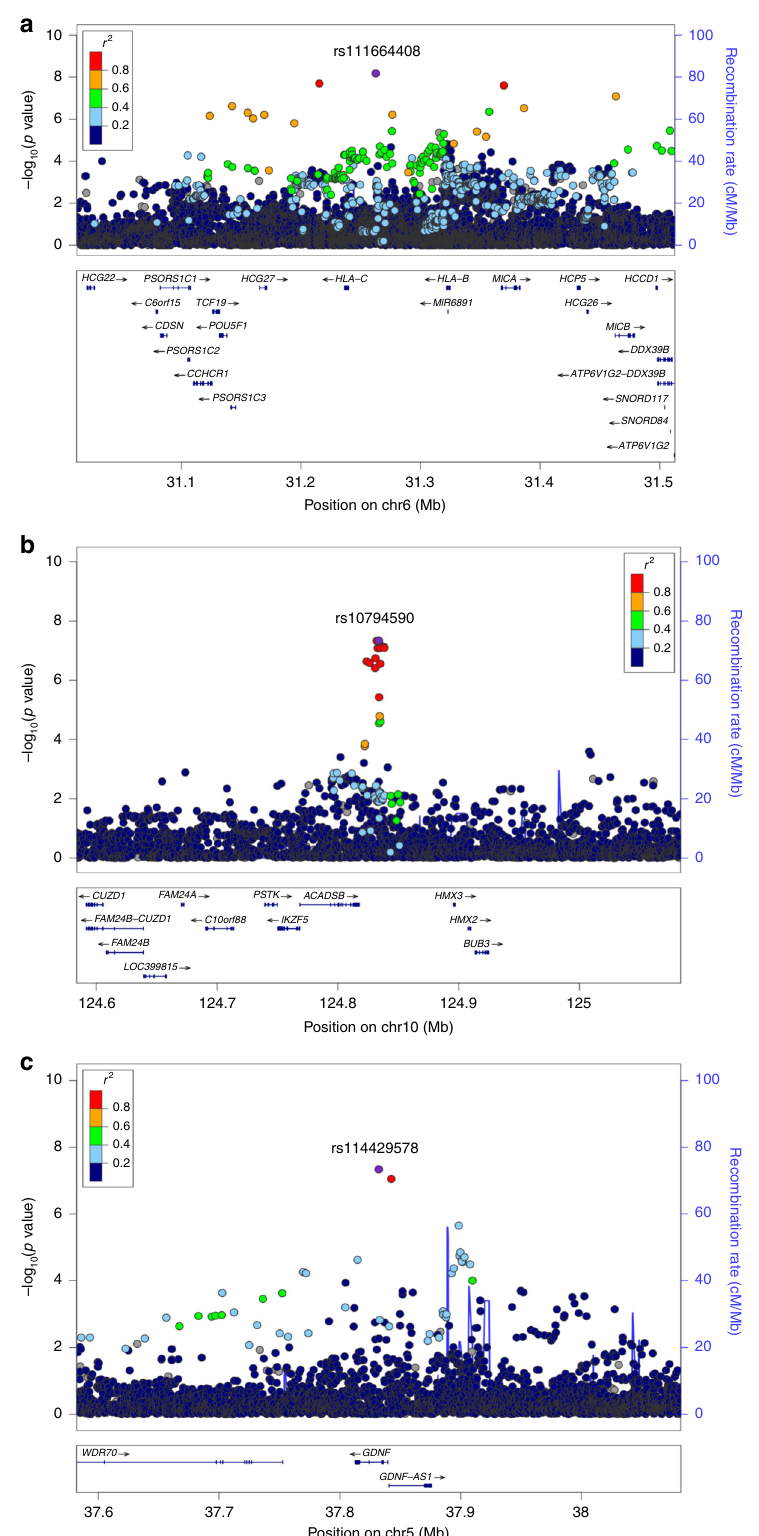
Fig. 4 Regional association plots for lead SNPs associated with anti-KSHV IgG levels p < 5 × 10 − 8 ), n = 4365 individuals. a Association on chromosome 6 in HLA class I region with anti-K10.5 IgG (rs111664408, p = 6.64 × 10 − 09 ). b Association on chromosome 10 in the ACADSB region with anti-K10.5 IgG (rs10794590, p = 4.59 × 10 − 08 ). c Association on chromosome 5 in GDNF region with anti-ORF73 IgG (rs114429578, p = 4.60 × 10 − 08 ). GWAS performed using linear mixed model accounting for kinship in GEMMA. The lead SNPs are labelled and coloured in purple. LD ( r 2 ) was calculated based on Ugandan SNP